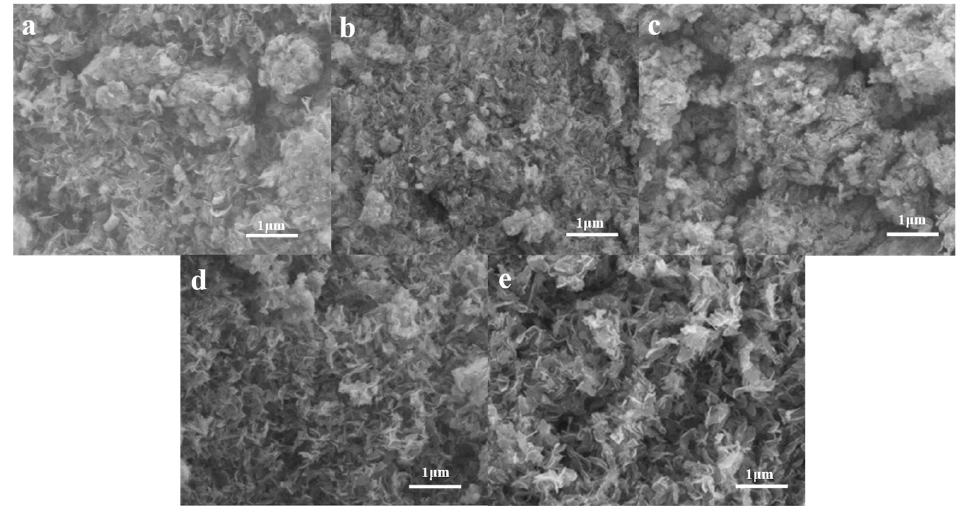
Figure 4. Scanning electron microscopy (SEM) images of AS1 after heat treatment from 20 to 1200 °C: ( a ) AS1-20, ( b ) AS1-600, ( c ) AS1-800, ( d ) AS1-1000, ( e )